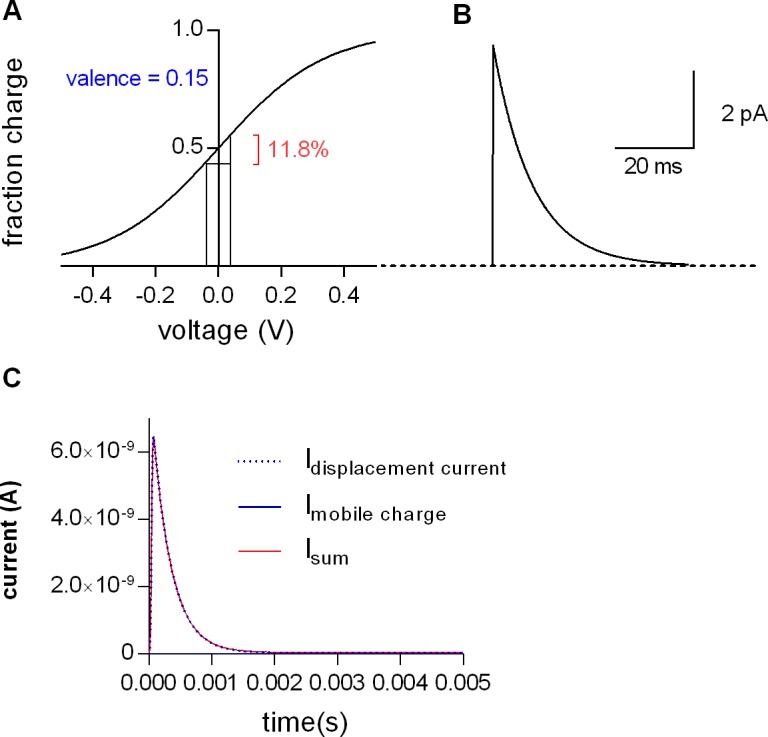
Mobile charges of SERT do not affect the measurements of membrane capacitance.(A) Simulated voltage dependence of mobile charges in SERT, as predicted by a simple two-state model. The valence of the mobile charge is 0.15 (Hasenhuetl et al., 2016), V0.5 was set to 0 mV. Shown in red is the maximal percentage of the total charge (11.8%) moved by a 80 mV voltage step (=voltage step used in the protocol to measure the membrane capacitance). (B) Simulated charge movement upon an 80 mV voltage step, assuming 2.107 transporters/cell and a transition rate of 100 s−1 (Hasenhuetl et al., 2016). The displayed trace is a convolution of the simulated current with the measured impulse response function of the patch-clamp amplifier. The initial amplitude of the simulated current is around 5 pA. (C) The blue dotted line is the simulated current response (=displacement current) of the equivalent circuit shown in Figure 9 to a step pulse from - 40 to +40 mV. The following circuit parameters were chosen: CM = 30 pF, RS = 107 Ohm, RM = 109 Ohm. The current response shown is the convolution of the simulated displacement current with the impulse response function of the patch-clamp amplifier. The blue line shows the simulated current produced by mobile charges of SERT, which is not visible at this scaling. The red line is the sum of the displacement current and the current produced by the mobile charge. Because the latter is so small the current is not changed to any appreciable extent by mobile charges of SERT moving in response to a voltage change.